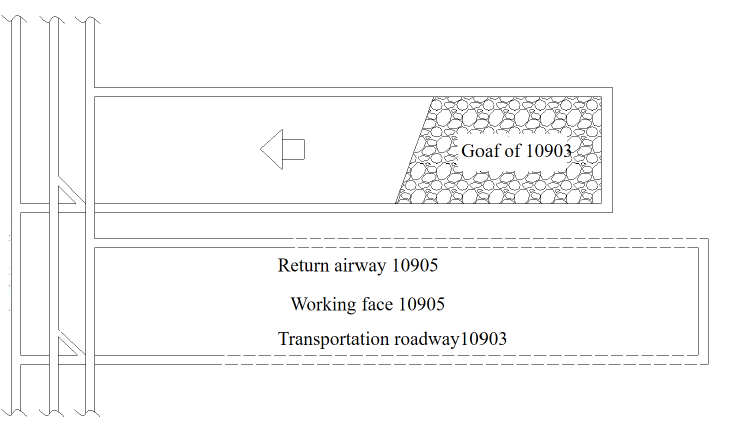
Figure 2. Arrangement of working face 10905.